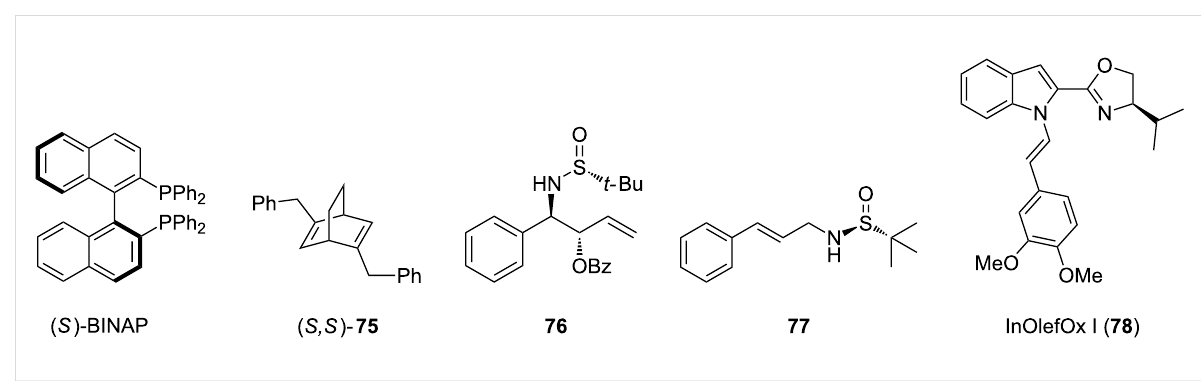
( 77 ) [161] ligands for the rhodium-catalyzed asymmetric